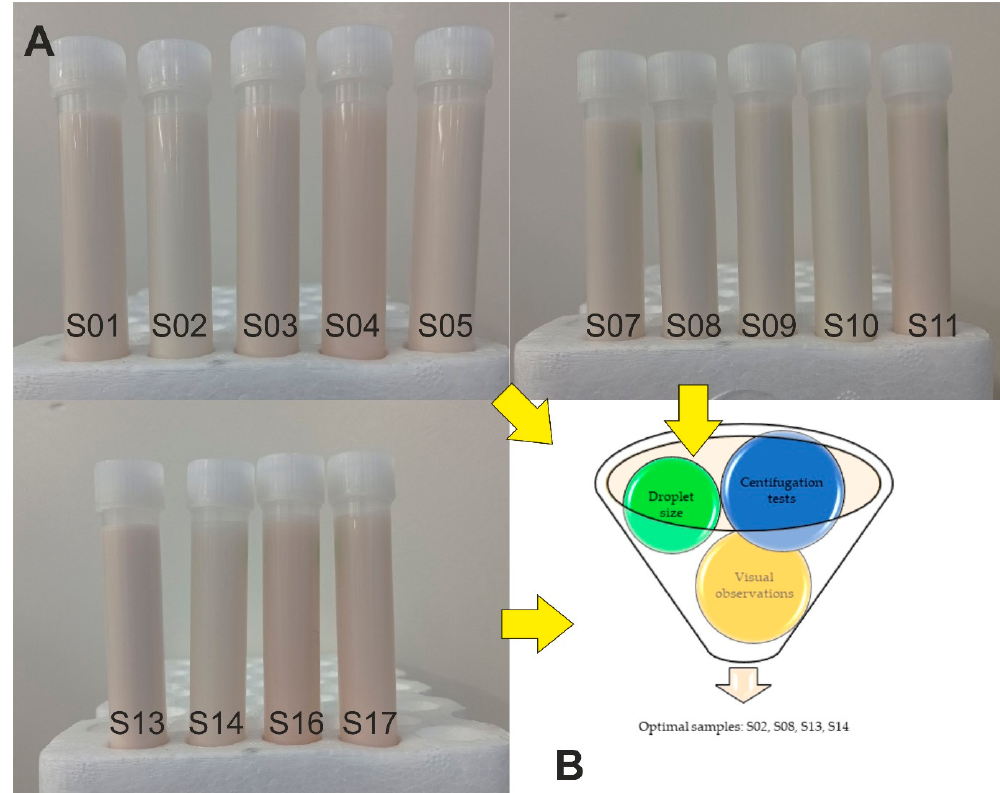
Figure 1. ( A ) The emulsion samples after 24 h. ( B ) Criteria of selecting the optimal samples composition for further studies. Table 2. Preliminary stability tests after centrifugation. OD C /OD 0 —ratio of the optical density at 600 nm of samples after and before